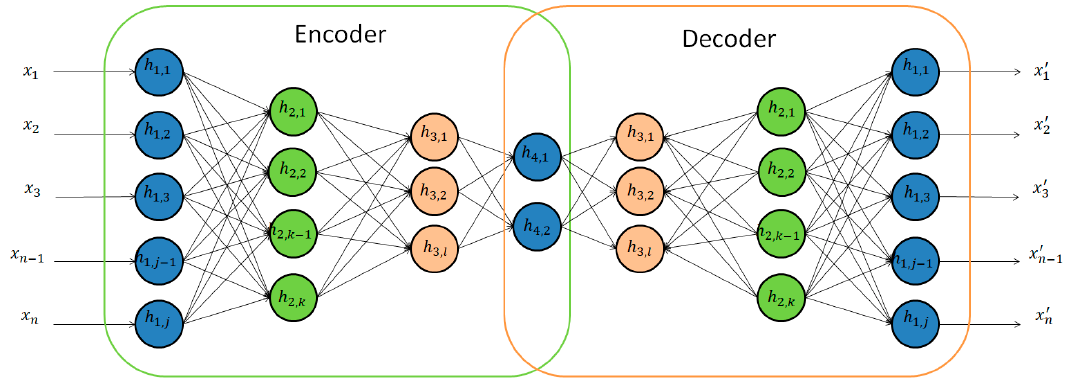
Figure 3. Deep Figure 3. Deep autoencoder.